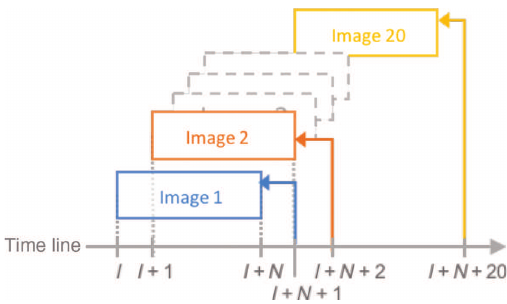
Figure 3: Process of Creating and Labeling Data in Workflow 1.